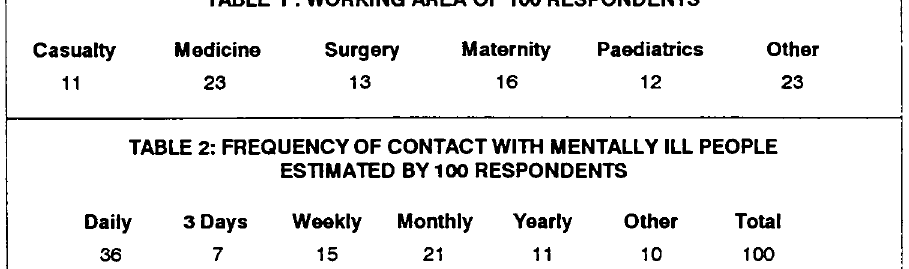
TABLE 1 : WORKING AREA OF 100 RESPONDENTS